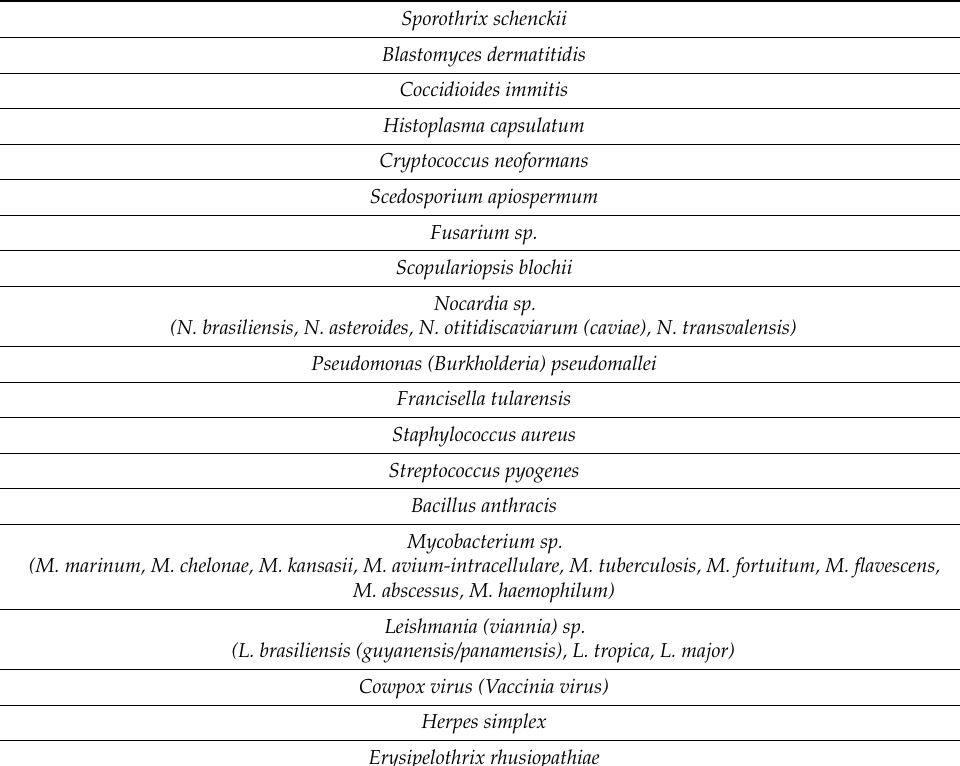
Table 1. Infectious causes of nodular